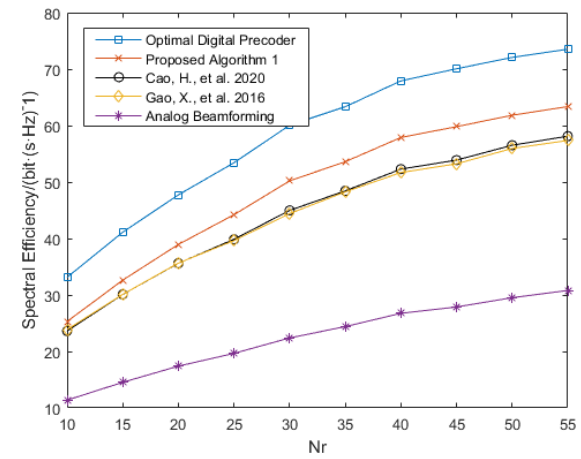
Figure 5. Spectral efficiency of different algorithms ( 𝑆𝑁𝑅 = 1𝑑𝐵 , N RF = 8, N s = 8). [18,21]